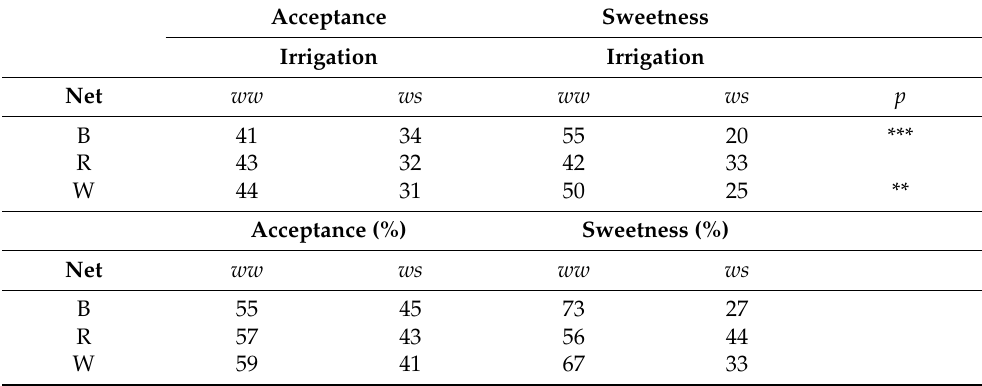
Table 10. Effect of shading and irrigation on consumer acceptance and sweetness perception for the year 2013. Values are expressed as number of consumers followed by p significance (upper table), and percentage (lower